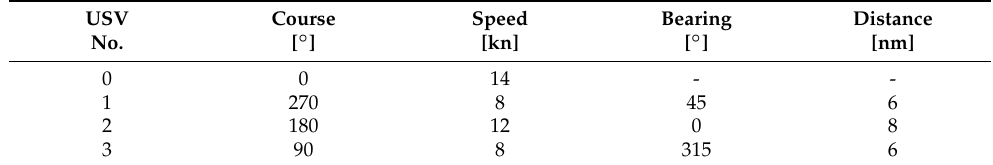
Table 9. Input data of test case 4.